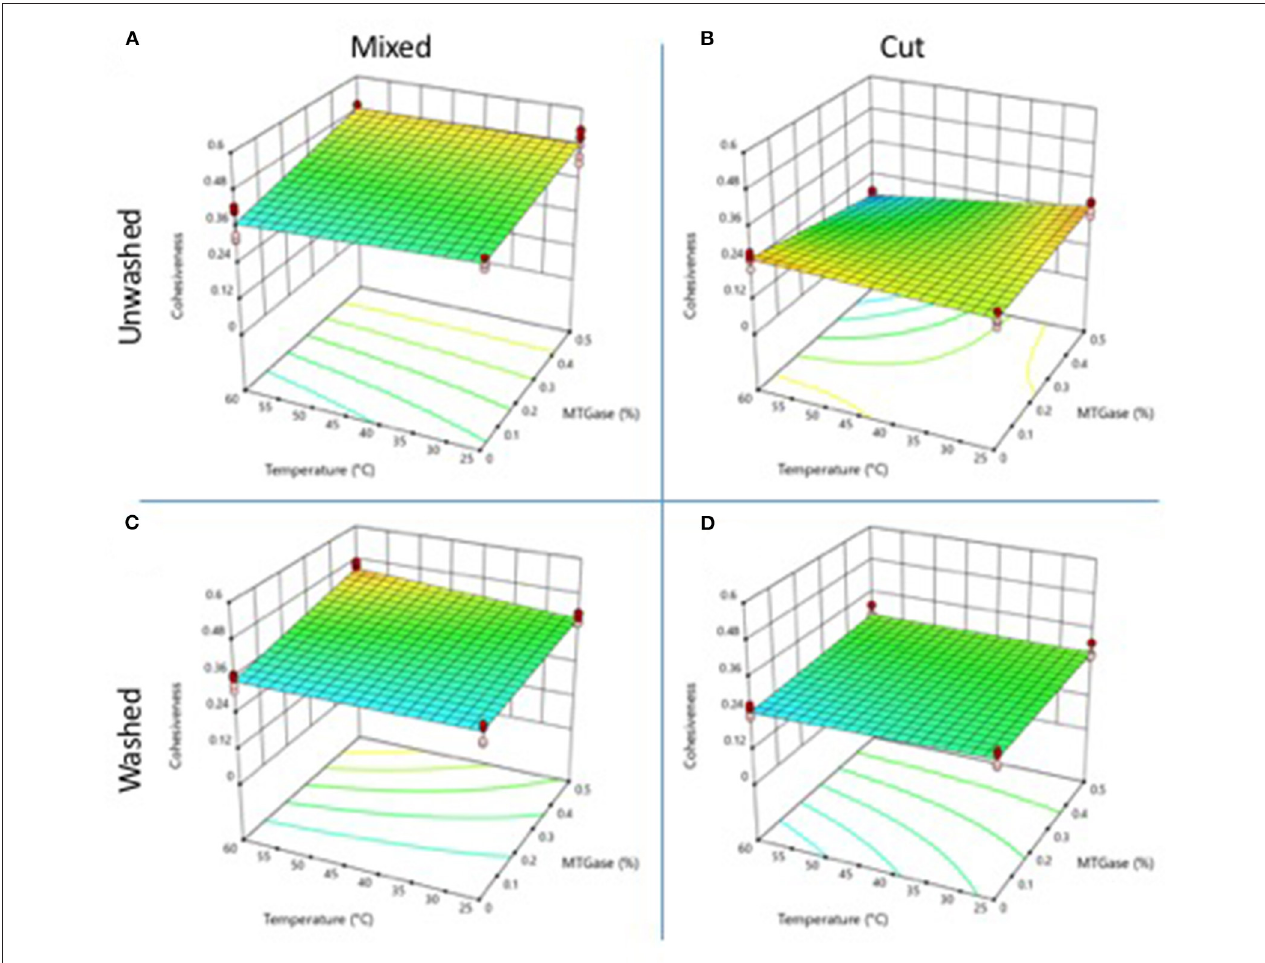
FIGURE 2 | Changes in gel cohesiveness properties as a function of the type and temperature mixing method, washing of the cooked meat, and adding of microbial MTGase. (A) Mixed-unwashed samples, (B) Cut-unwashed samples, (C) Mixed-washed samples, and (D) Cut-washed